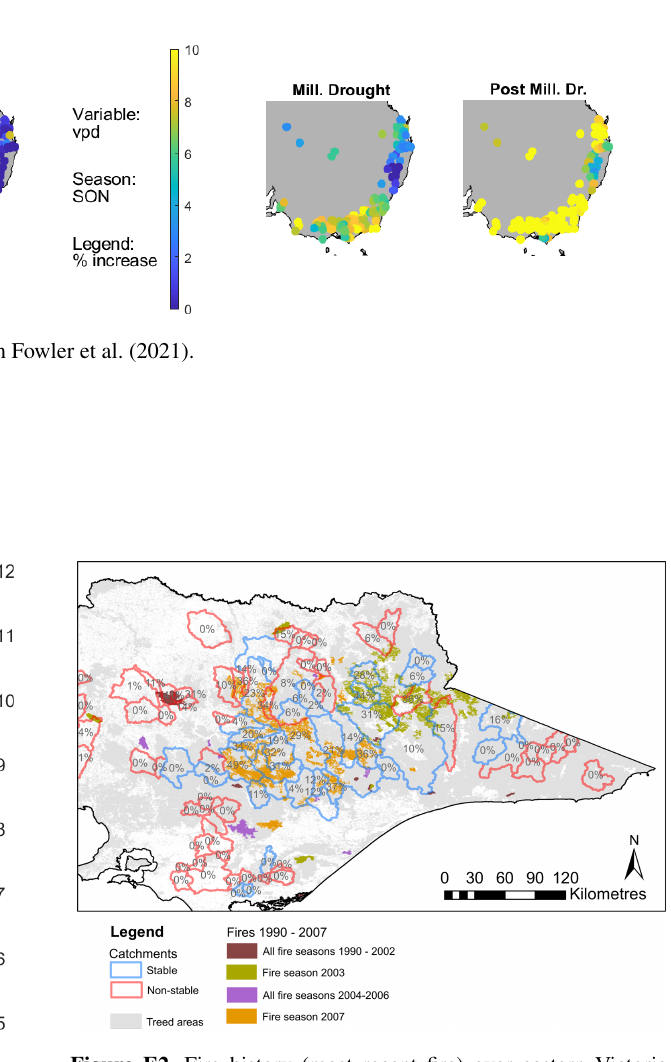
Figure E1. Number of years that met the definition of prior droughts used to create Fig. 5, for each catchment. Based on data from Fowler et al. (2021).